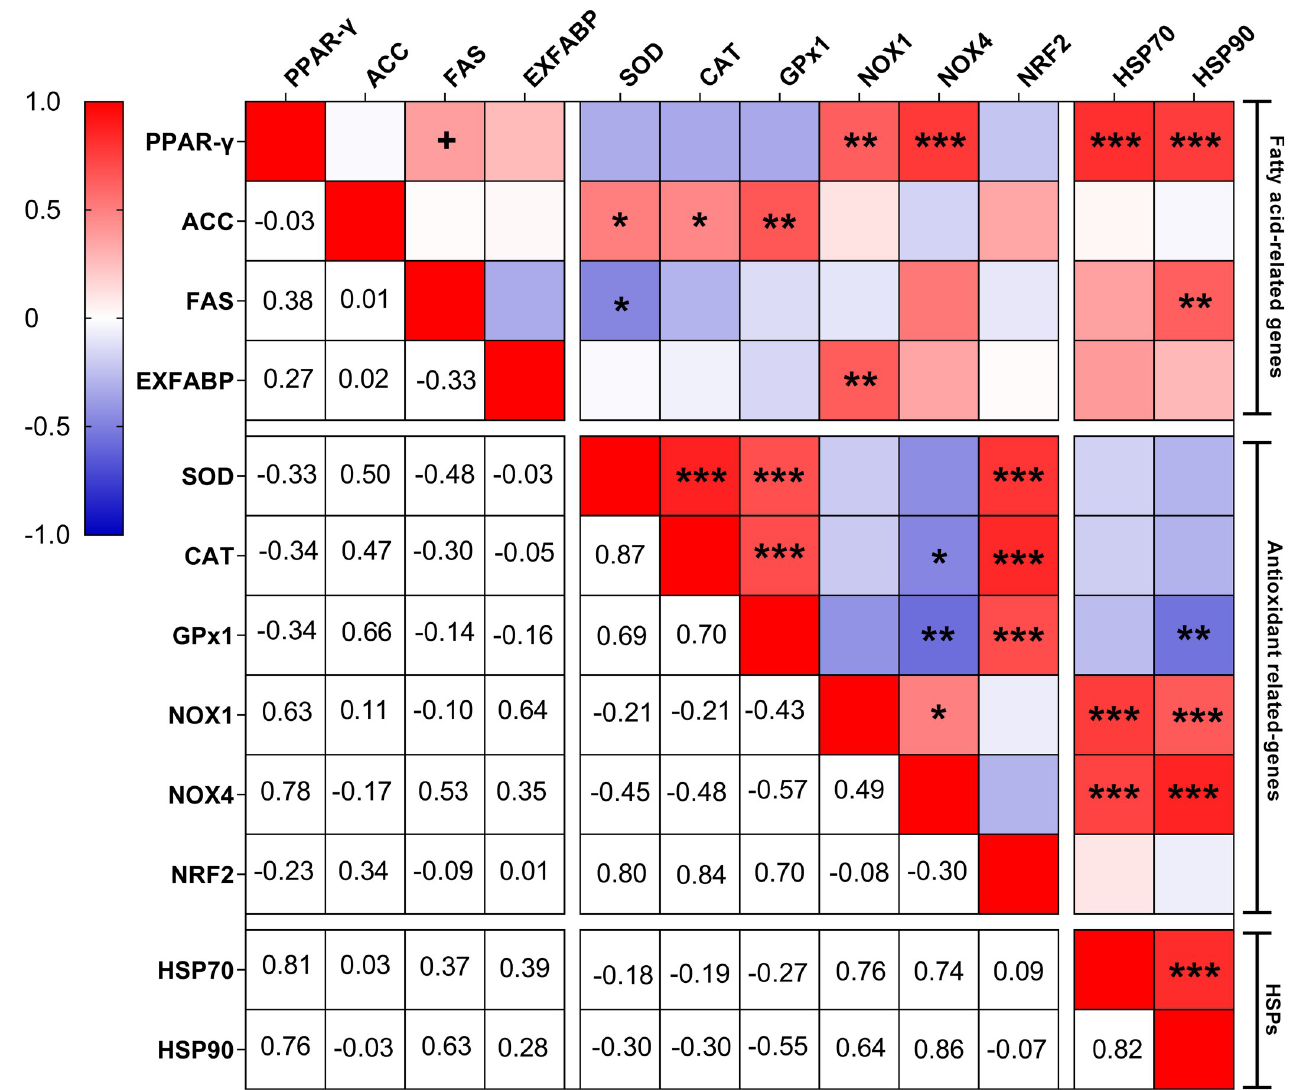
Fig 6. Pearson correlation heat map between the relative mRNA levels of the genes studied. The red color indicates a positive correlation, the blue color indicates a negative correlation and the white color indicates no correlation. Pearson r values were calculated using the “CORR procedure” of the SAS software version 9.4 (SAS Institute Inc., 2009). Abbreviations: ACC, acetyl-CoA carboxylase; CAT, catalase; EXFABP, extracellular fatty acid-binding protein; FAS, fatty acid synthase; GPx1, HSP70, heat-shock protein 70; HSP90, heat shock protein 90; glutathione peroxidase 1; NOX1, nicotinamide adenine dinucleotide phosphate oxidase 1; NOX4, nicotinamide adenine dinucleotide phosphate oxidase 4; NRF2, nuclear factor erythroid 2-related factor 2; PPAR- γ , peroxisome proliferator-activated receptor-gamma; SOD, superoxide dismutase. + Correlation is significant at the P < 0.1. � Correlation is significant at the 0.05 level. �� Correlation is significant at the 0.01 level. ��� Correlation is significant at the 0.001